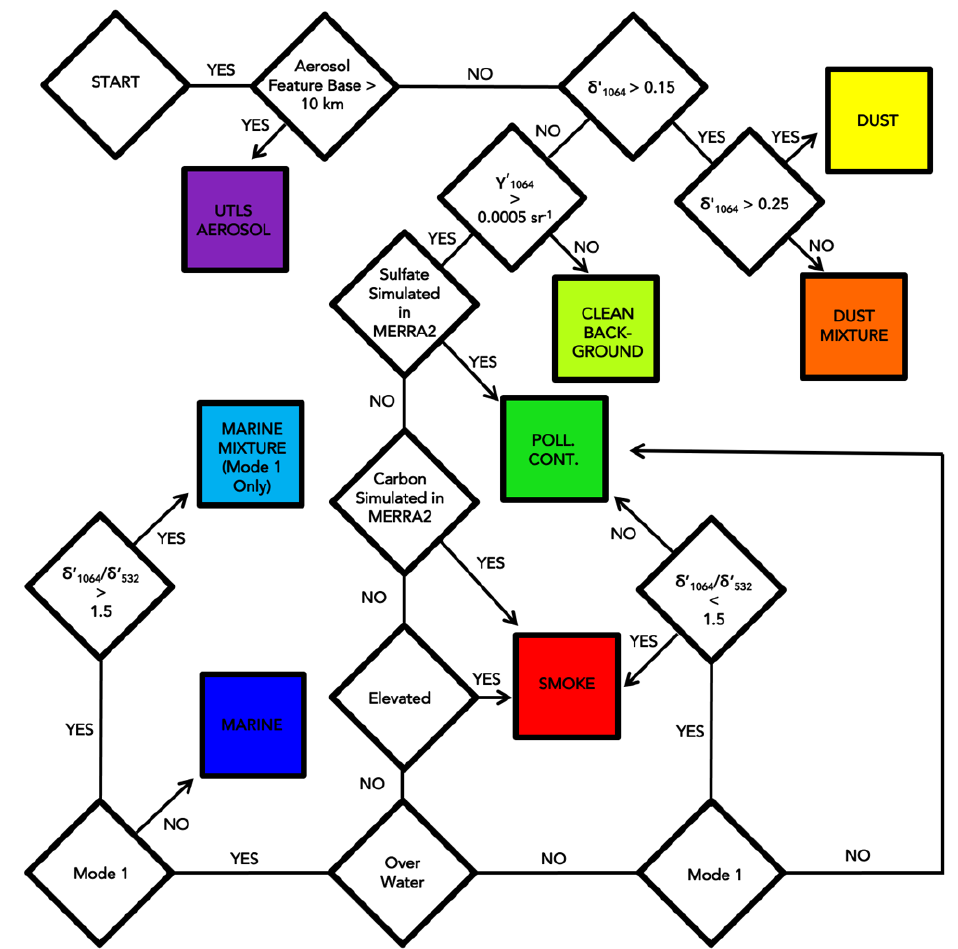
Figure 1. Schematic of the CATS aerosol-typing algorithm for both science